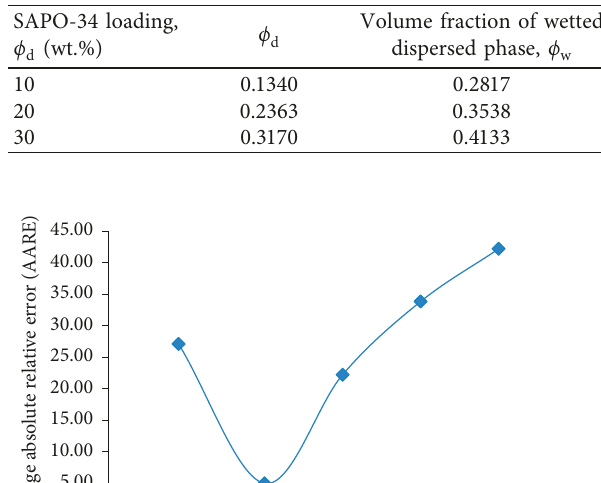
Table 4: Fitted ϕ w values against SAPO-34 volume fraction of IL3M-emim[Tf 2 N].